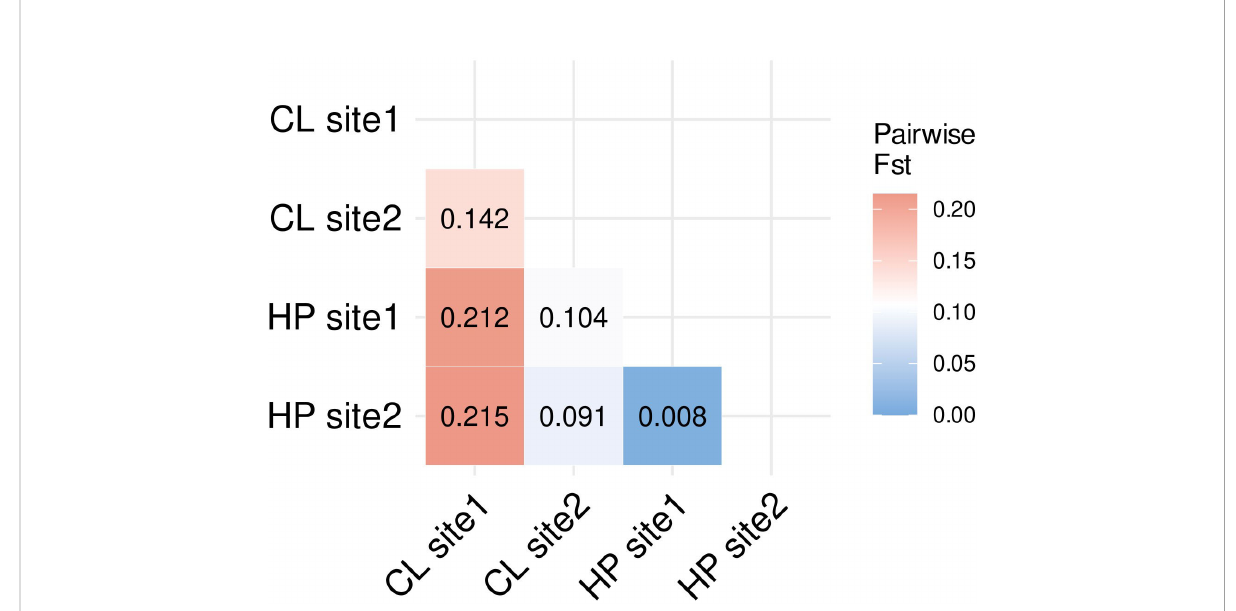
FIGURE 5 Pairwise F ST estimates among all sampling sites using clone-corrected data. CL and HP refer to clonal and haplodiplontic